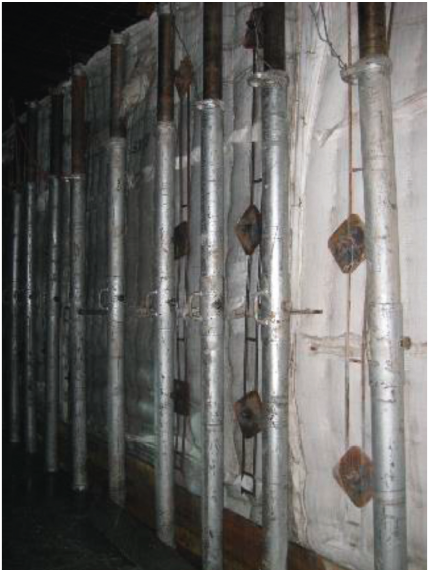
Figure 15: Effect of field